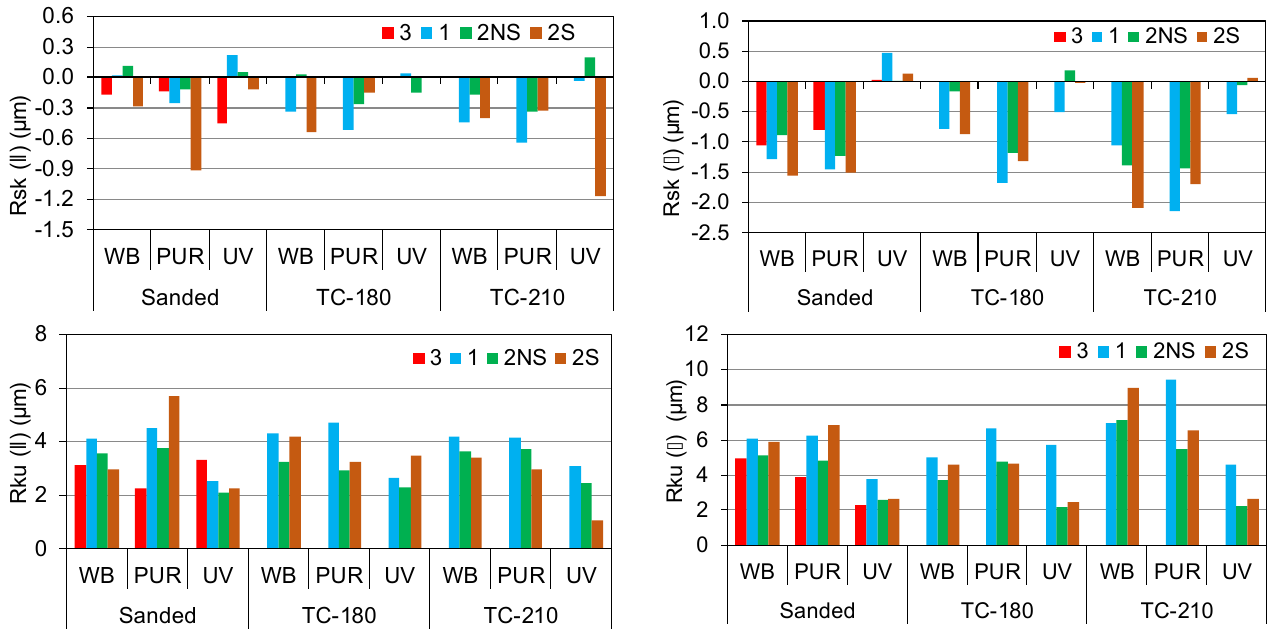
Figure 2. Surface roughnesses of alder wood samples along and across the fibers.